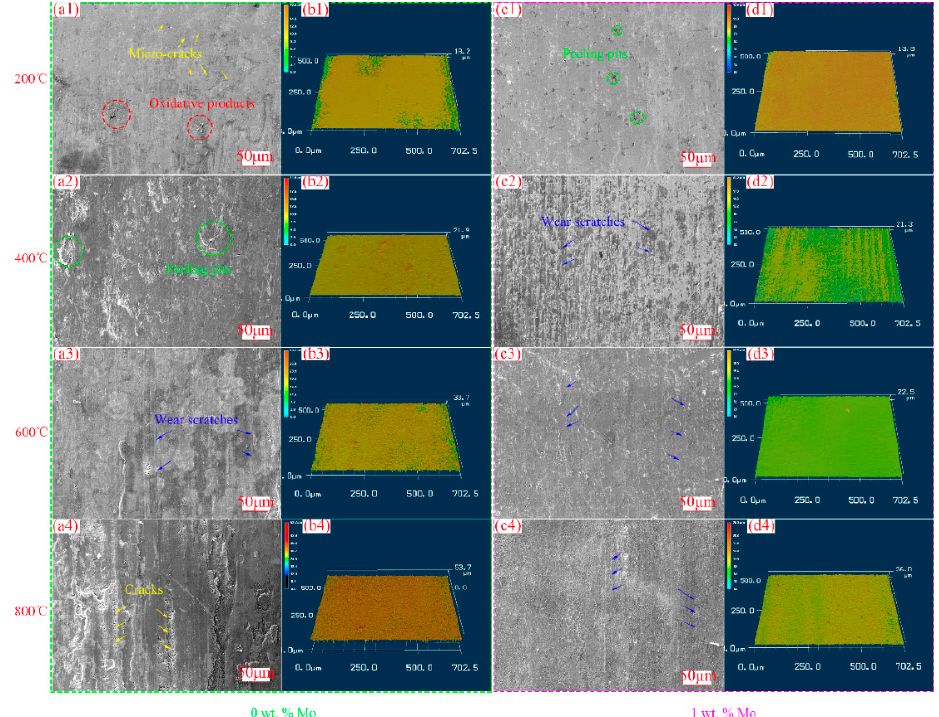
Figure 3. SEM and 3D laser scanning morphologies of the wear surface for the specimens without Mo and with 1.0 wt. % Mo addition at different temperature: ( a1 – b4 ) the specimen without Mo, ( c1 – d4 ) the specimen with 1.0 wt. % Mo addition.